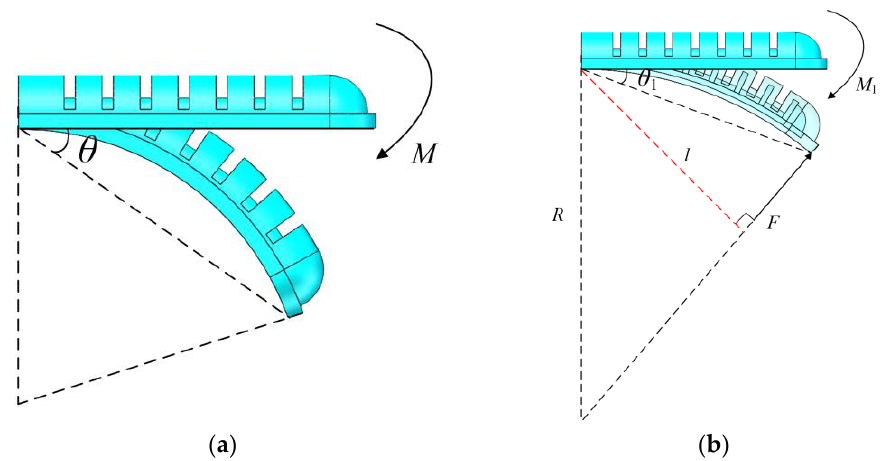
Figure 11. Flexible rod large-deformation equivalent model. ( a ) Free bending state of soft actuator. ( b ) After the soft actuator is bent to a free state, a reverse thrust is applied. Then, the end-output force of the soft actuator can be listed as